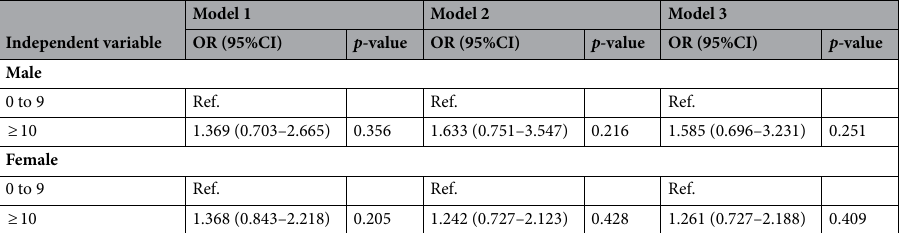
Table 3. Binary logistic regression of sarcopenia, showing effects as odds ratios and 95% confidence intervals. Model 1: adjusted for age, BMI, district. Model 2: adjusted for age, BMI, district, IPAQ, monthly income, education, smoking, drinking, denture status. Model 3: adjusted for age, BMI, district, IPAQ, monthly income, education,smoking, drinking, denture status, depression, nutrition status, hypertension, diabetes. OR odds ratio, CI confidence interval.